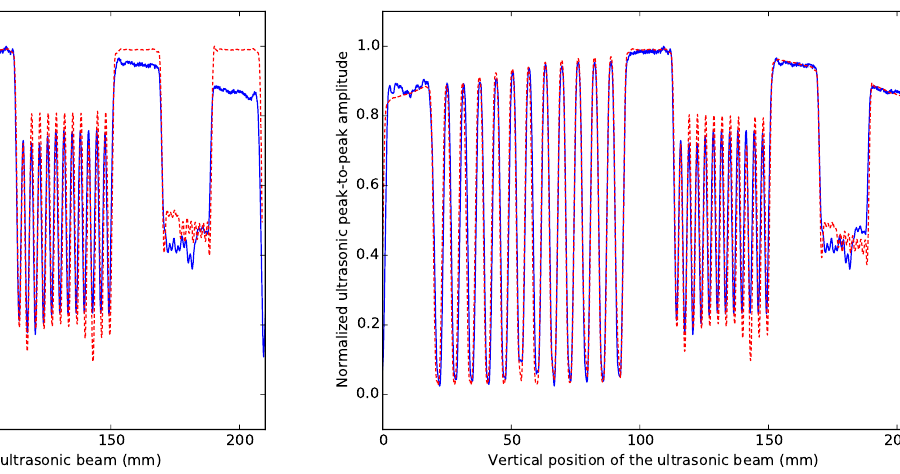
Fig. 11. One-dimensional C-scan of the amplitude of the water experiment. Red dotted: CIVA simulation, blue: experiment. cal data from CIVA simulation with full incident beam setting.